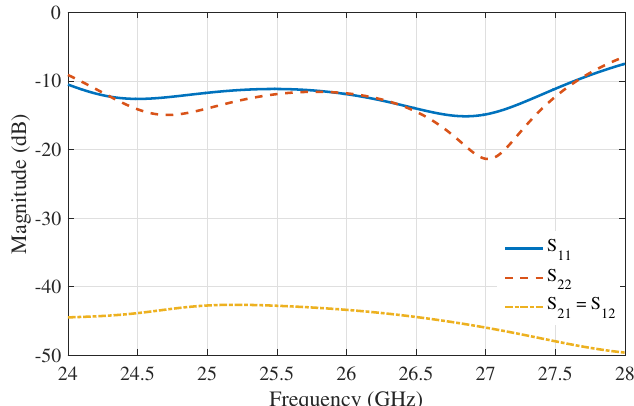
Figure 13. Simulated results for the magnitude of V-Pol (port 1) and H-Pol (port 2)